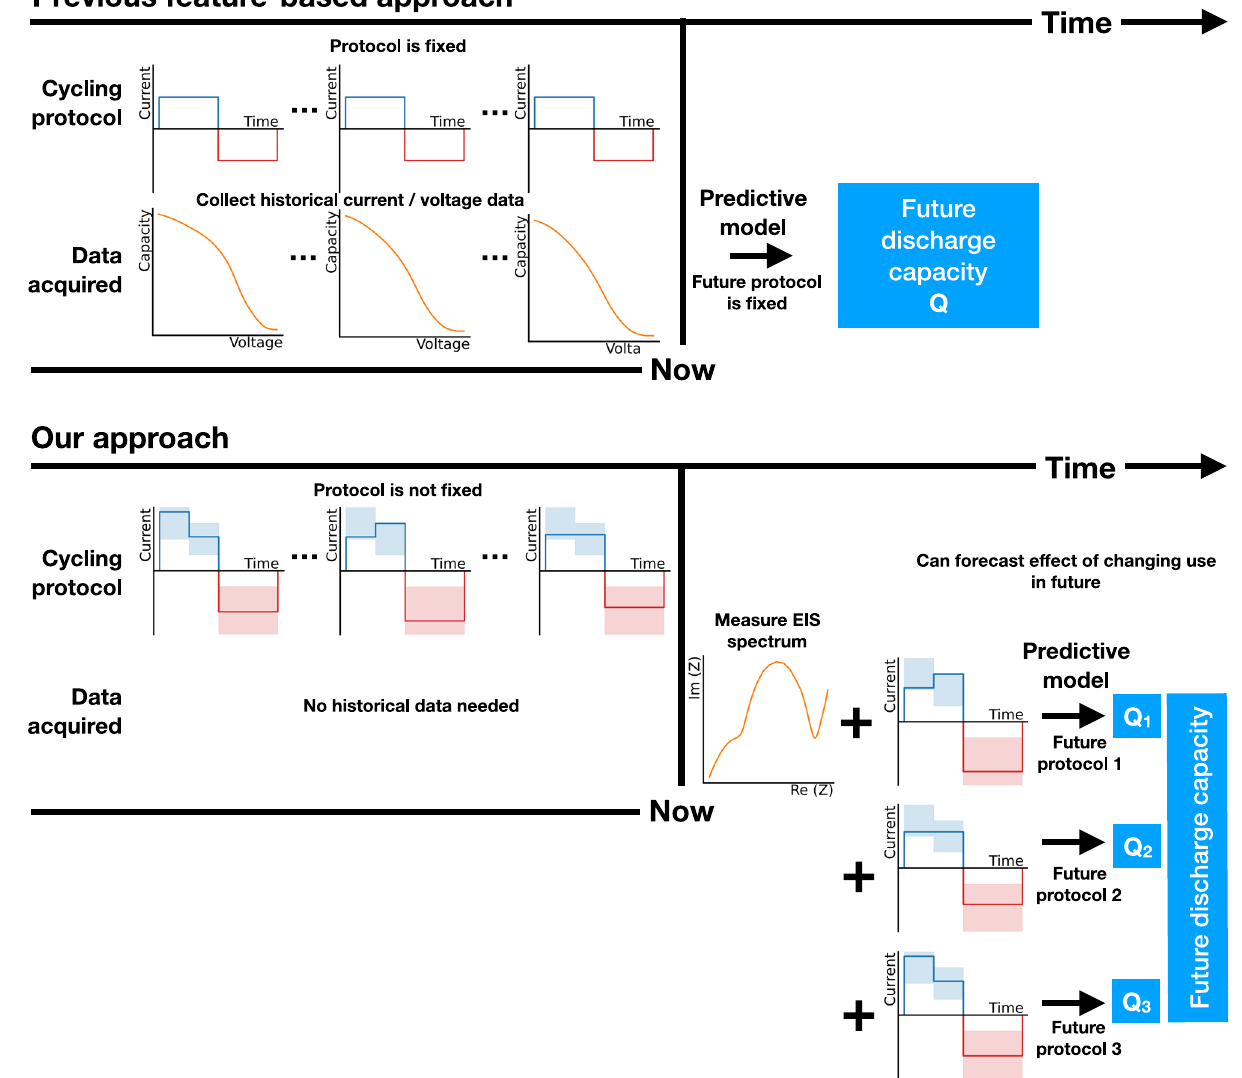
Fig. 1 | Schematic comparison of the proposed approach to previous research works. Feature-based methodologies for degradation prediction have focused on constant charging protocols (the blue/red curve denotes the charge/discharge phase), using features from capacity – voltage curves as input 22,51 . This necessitates knowledge of historic charging data. Our approach considers variable charging